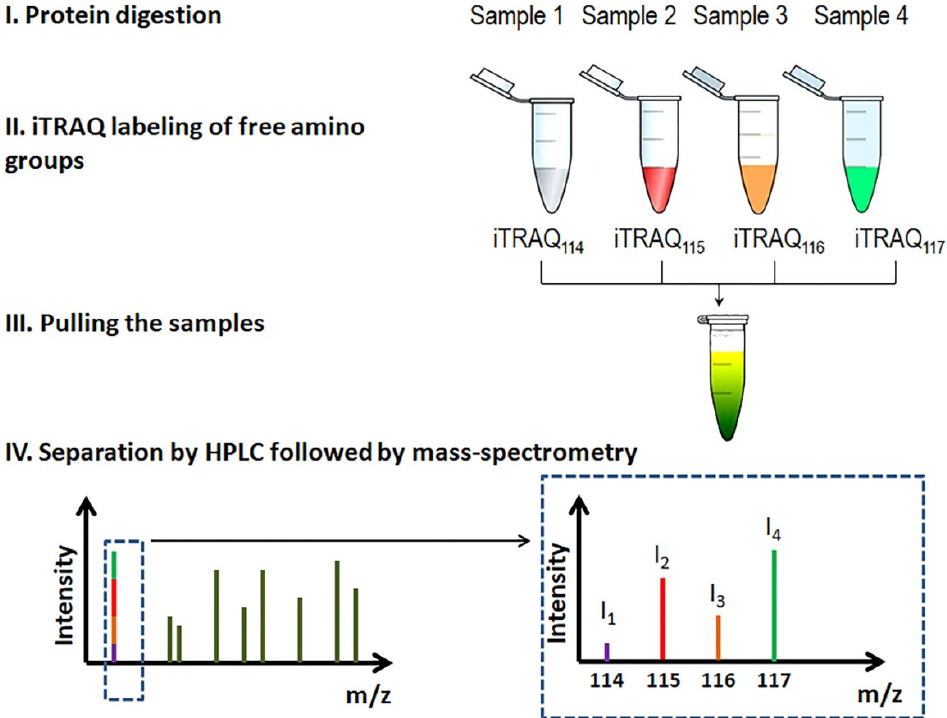
Figure 3. iTRAQ workflow. Several samples are separately digested and labeled with iTRAQ tags of different molecular weights and pulled. The labeled peptides are separated by HPLC followed by mass spectrometry. During mass spectrometry, tags become released from the peptide. The ratio of the iTRAQ ions is used to assess the sample-specific content of a particular peptide.